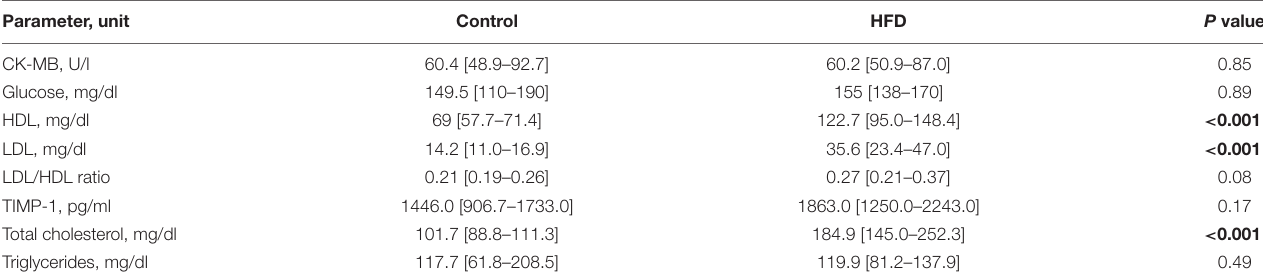
TABLE 1 | Blood sample analyses.